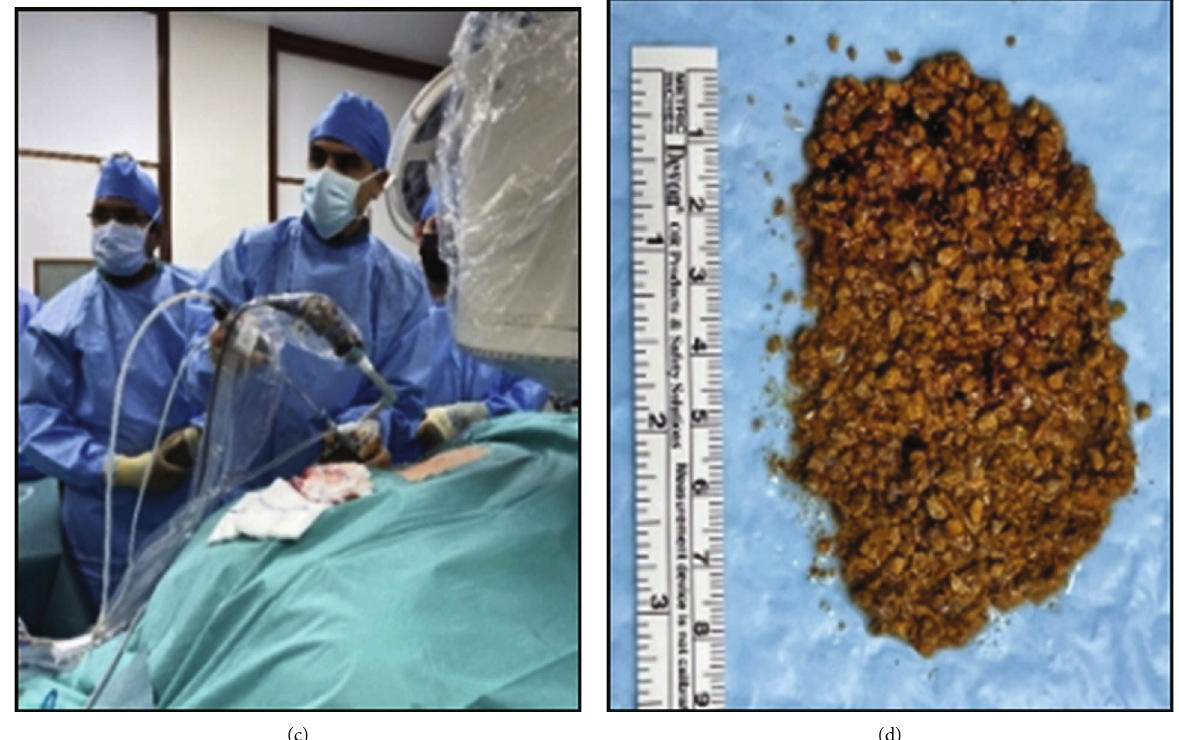
Figure 2: (a) Patient in prone positioning. (b) Alken dilators. (c) PCNL procedure. (d) Patient ’ s stone